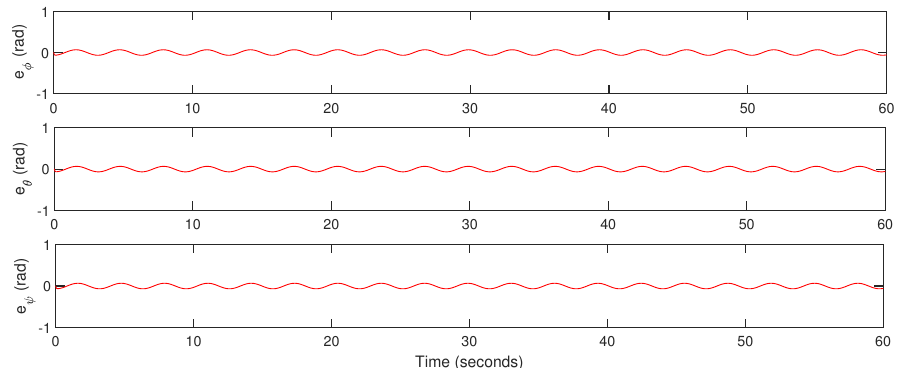
Figure 16. Estimation error of attitude subsystem when [sin ( 2 t ) sin ( 2 t ) sin ( 2 t ) ] is applied to the attitude